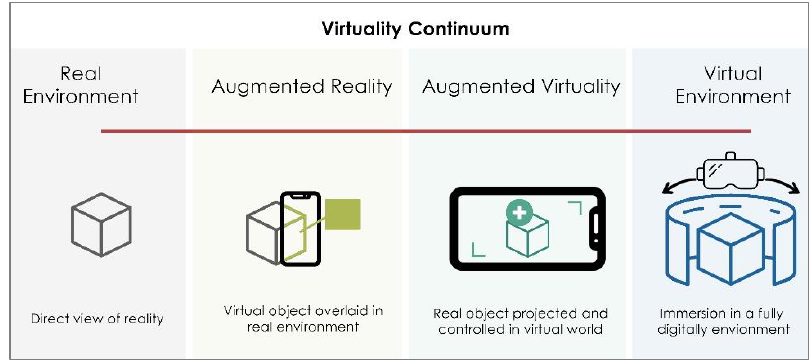
Figure 1 Reality-Virtuality continuum. Authors after Milgram and Kishino (1994).